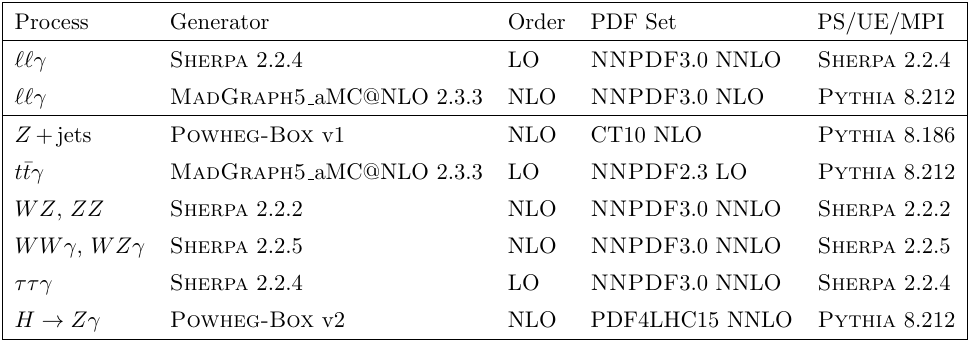
Table 1 . Summary of simulated MC event samples for the ‘ + ‘ (cid:0) (cid:13) signal process ((cid:12)rst two rows) and for various background processes (lower six rows). The third and fourth columns give the pQCD order and the PDF set used in the hard-scattering matrix element calculations. The rightmost column speci(cid:12)es the generator used to model parton showering, hadronisation, the underlying event and multiple parton